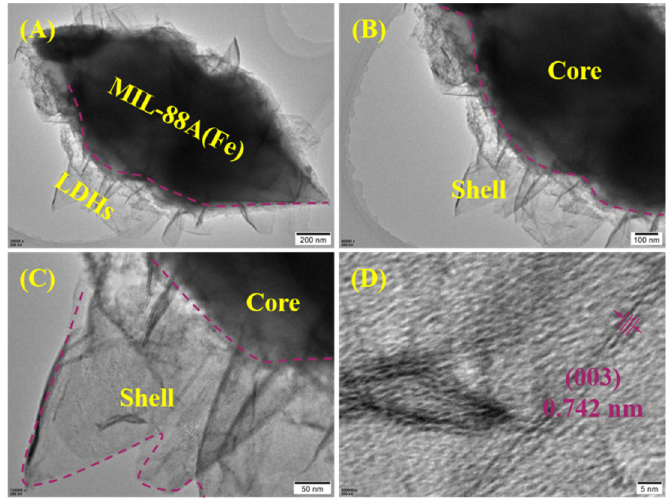
Figure 3. TEM images at different magnifications (A–C) and high-resolution TEM image (D) of MIL-88A-LDHs. ( D ) of MIL-88A-LDHs.